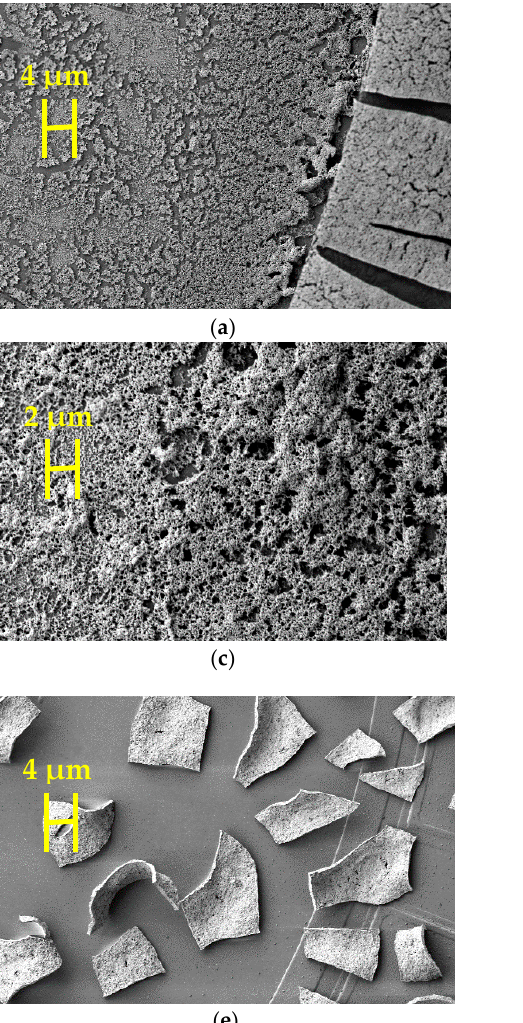
test at 130 °C, 110 °C and 90 °C operating temperature) at 1.5% continuous hydrogen flow for ( a ) Pt- 24 h test at 130 ◦ C, 110 ◦ C and 90 ◦ C operating temperature) at 1.5% continuous hydrogen flow for